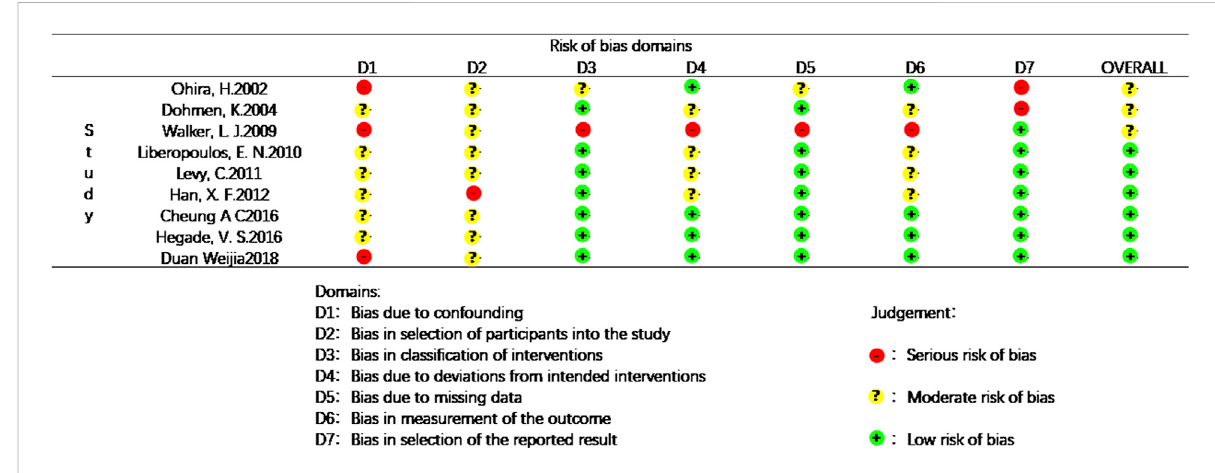
FIGURE 4 Risk of bias in the included studies based on Robins-I.